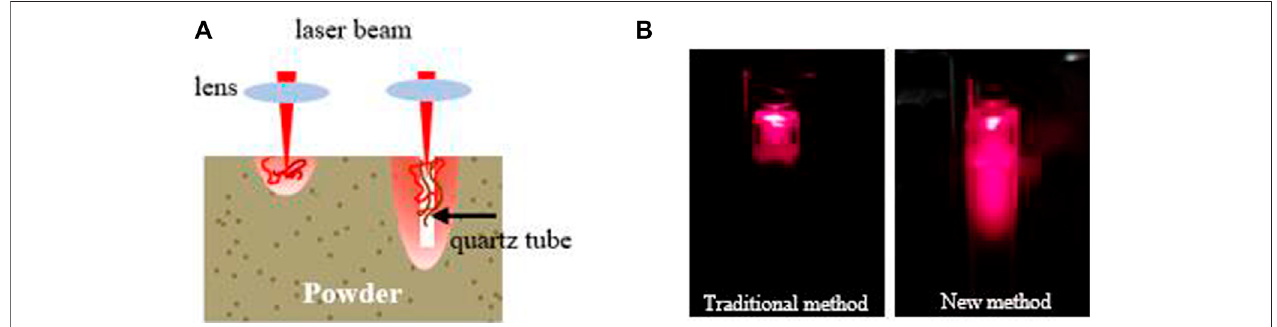
FIGURE 1 | (A) Diagram of two types of detection methods: traditional and Quartz tube enhanced Raman spectroscopy technology and (B) Image of scattering from a powder sample acquired using a cell phone camera: traditional and Quartz tube enhanced Raman spectroscopy technology.